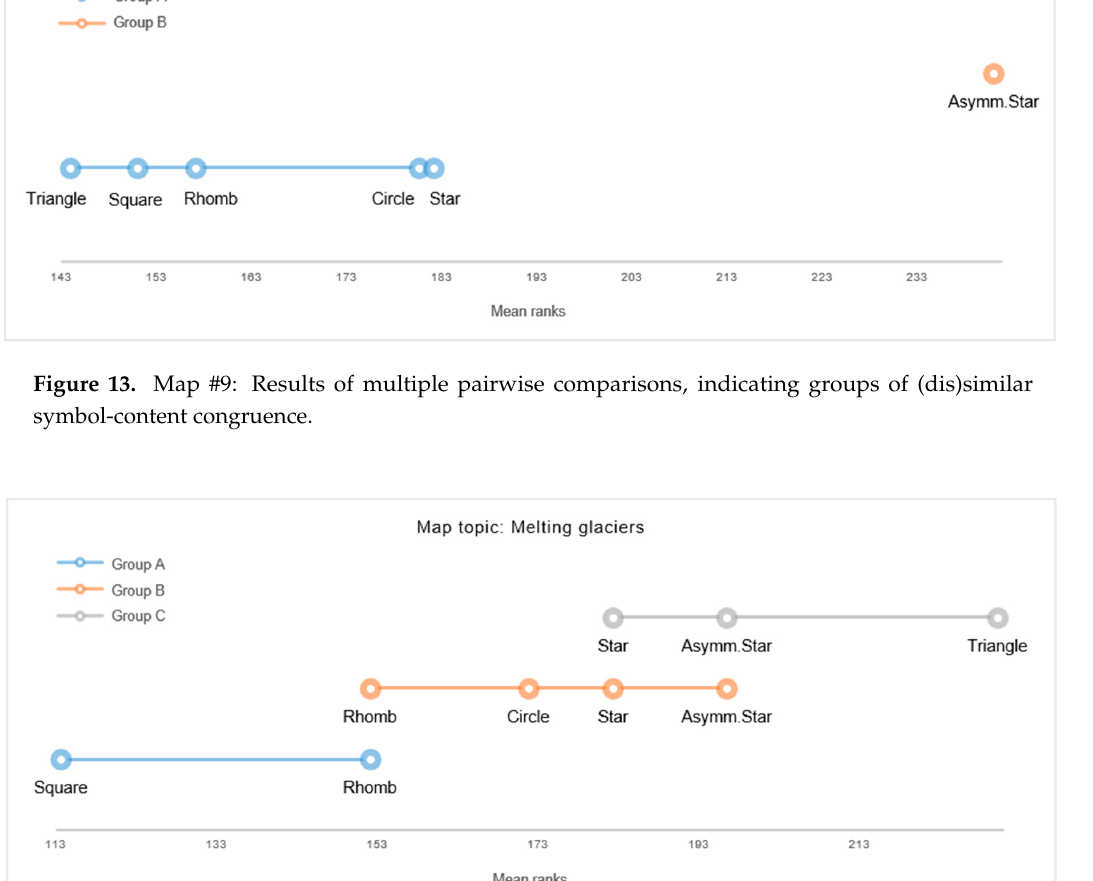
Figure 14. Map #10: Results of multiple pairwise comparisons, indicating groups of (dis)similar symbol-content congruence.